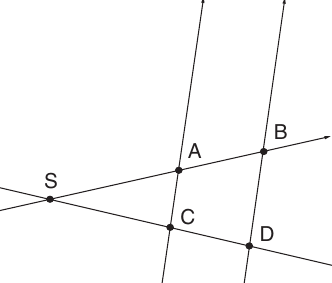
Fig. 6. Limb schematics.